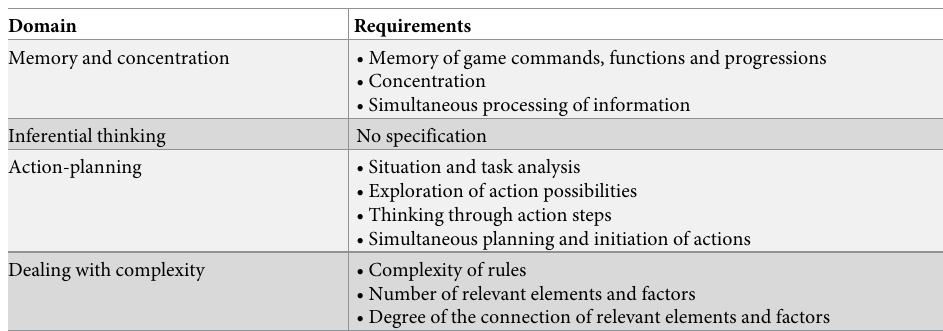
Table 1. Cognitive requirements catalogue